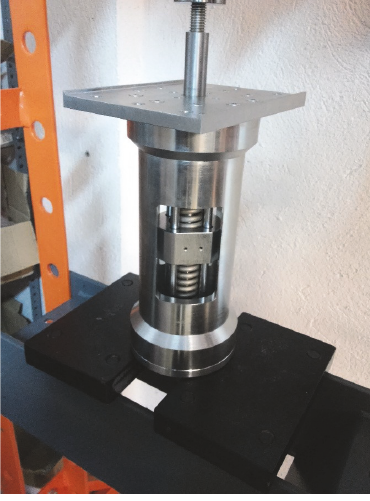
Figure 11: 𝑍 -transmitter first setup.